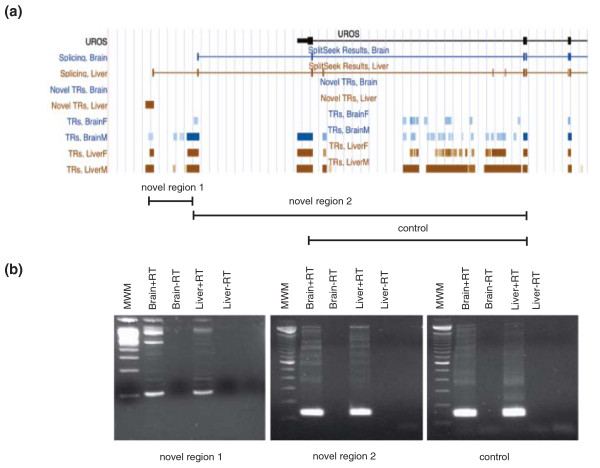
Example of a novel 3' UTR in the UROS gene. (a) The structure of the UROS gene from the UCSC Genome Browser. At the top is a schematic view of the RefSeq gene with exons as black boxes and introns as connective lines. Below are two tracks with predicted splicing events, then follows a set of tracks with detected TRs in the two tissues and at the bottom is a representation of the primers and the experimentally validated junctions between TRs. (b) The experimental validation with RT-PCR. The two TRs representing the novel 3' UTR are on the first two gels and a positive control of the main transcript is on the third gel. The first lane on the gels is 100 bp ladder (molecular weight marker, MWM), then follows the brain sample with (+RT) and without (-RT) reverse transcriptase, followed by the same set of experiments in the liver sample.